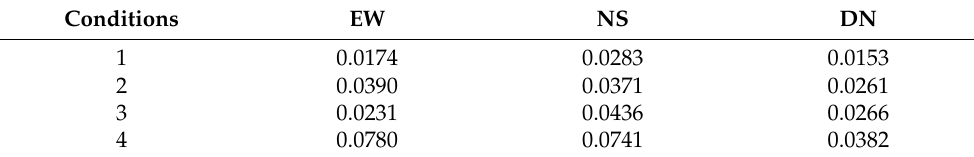
Figure 6. Influence of unavailable on the result of similarity. Table 2. Maximum standard deviations for different conditions of unavailable